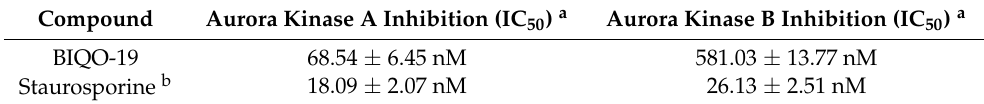
Table 2. Effect of BIQO-19 on the enzyme activity of aurora